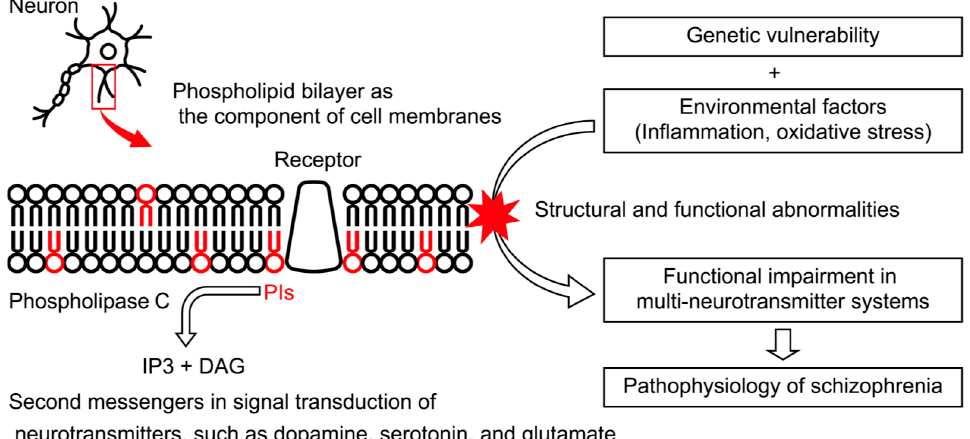
Figure 2. Schematic diagram of the association between phosphoinositides (PIs) and pathophysiology of schizophrenia. PIs are one of the components that make up the cell membrane of neurons. PIs also function as second messengers for neurotransmitter signaling. The signaling of dopamine, serotonin, and glutamate, which is associated with schizophrenia, converges with the activation of phospholipase C (PLC) and the production of inositol trisphosphate (IP3) and diacylglycerol (DAG) as second messengers from PIs. In schizophrenia, genetic vulnerability and environmental factors may lead to functional impairment in multi-neurotransmitter systems through structural and functional dysfunction of PIs.